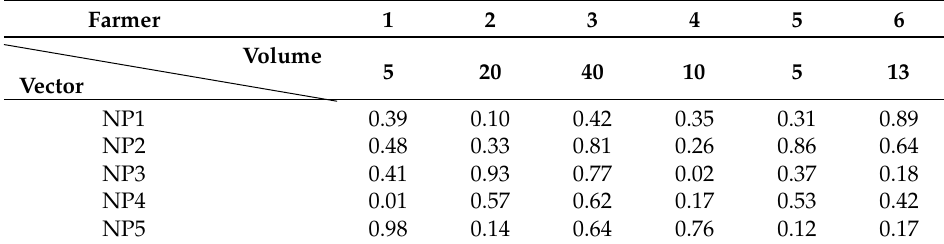
Figure 1: Assigning random code numbers to each vector in each